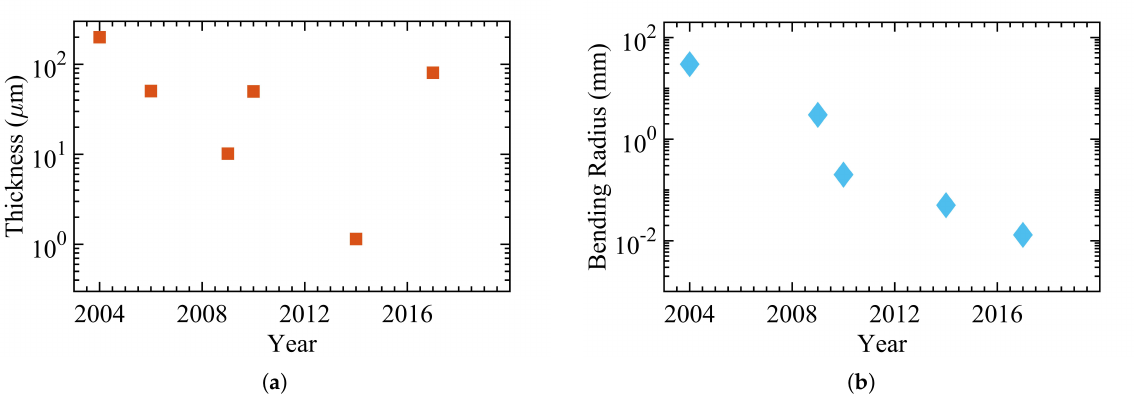
Figure 7. The progress of oxide TFTs with ( a ) the total thickness and ( b ) the bending